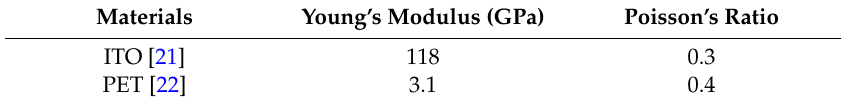
Figure 7. Finite element analysis (FEA) model of patterned ITO/PET film utilized in stress–strain simulation: ( a ) pattern 1 (ITO width = 3.92 mm); ( b ) pattern 2 (ITO width = 0.37 mm). Table 3. Material properties used in stress–strain simulation of patterned ITO/PET film. Materials